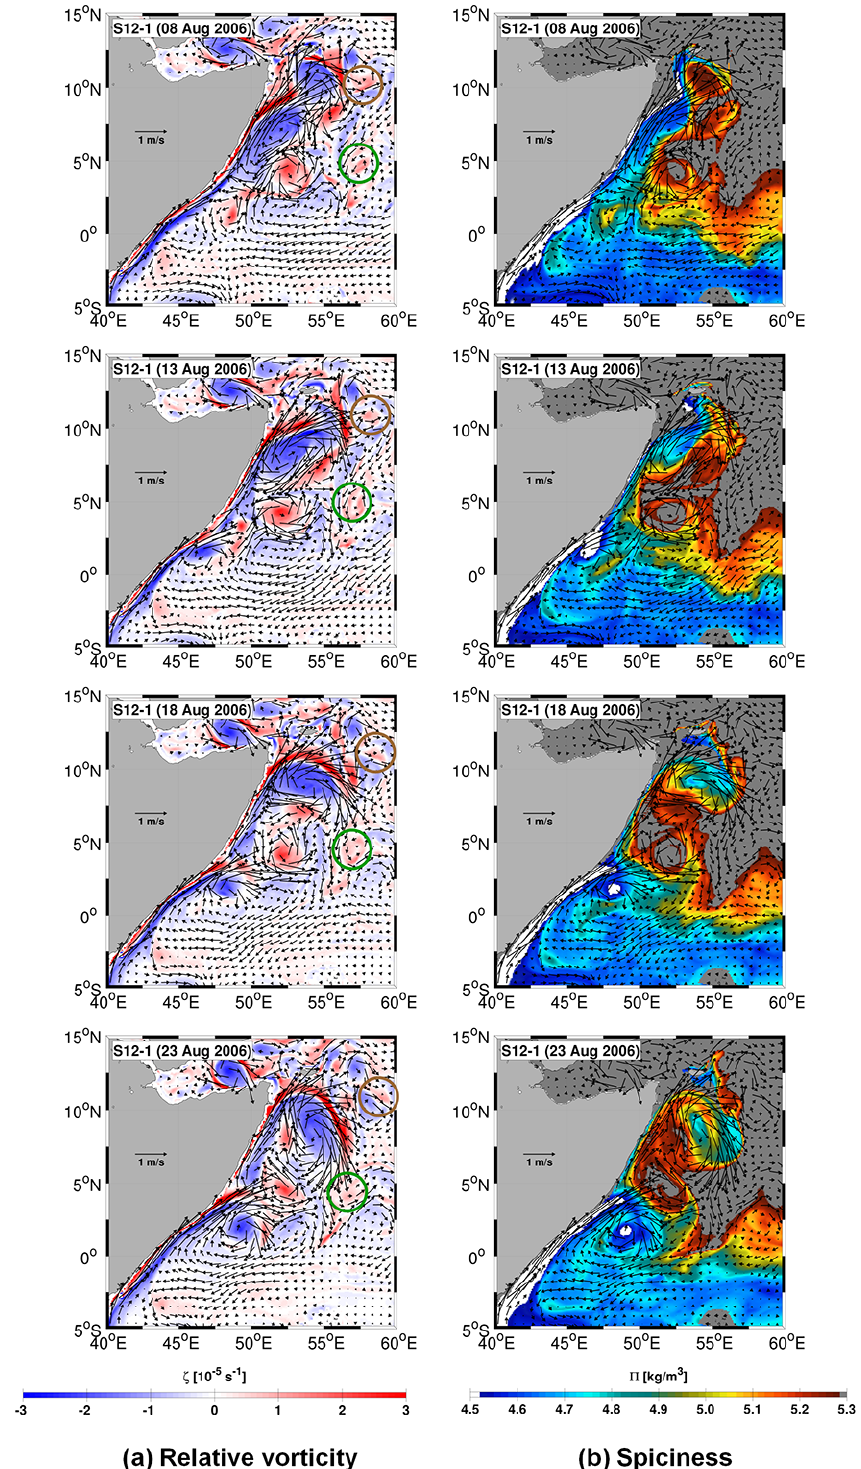
Figure 7. Snapshots of current (vectors; ms − 1 ) at 50m superimposed on (a) relative vorticity ( ζ ; colour shading; s − 1 ) at 50m and (b) spici- ness on isopycnal σ 0 = 23.8 ( (cid:53) ; colour shading; kgm − 3 ), between August and October in 2006 in the 1 / 12 ◦ S12-1 simulation. The green and brown circles outline cyclonic vortexes generated from